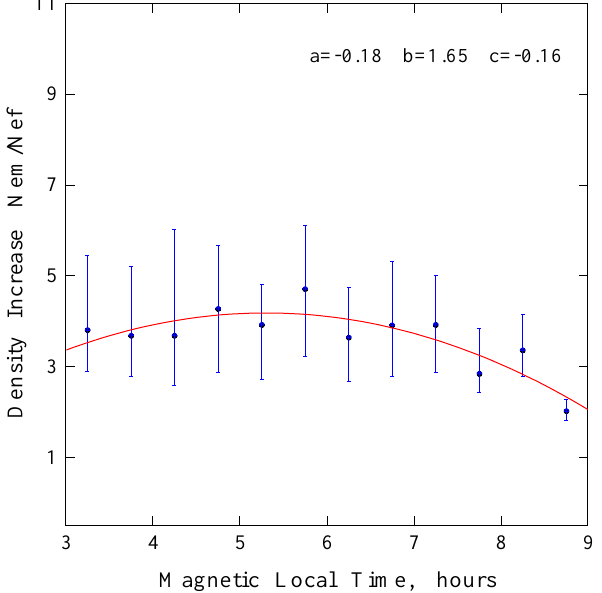
Fig. 9. Relative density increase in the polar cliff as function of magnetic local time. The format of data presentation corresponds to that in Fig. 6, except that this time a polynomial of the form a + b · MLT + c · MLT 2 has been fitted to the median values. Again, the data refer to a geographic longitude of 0 ◦ , and an altitude of 400km.